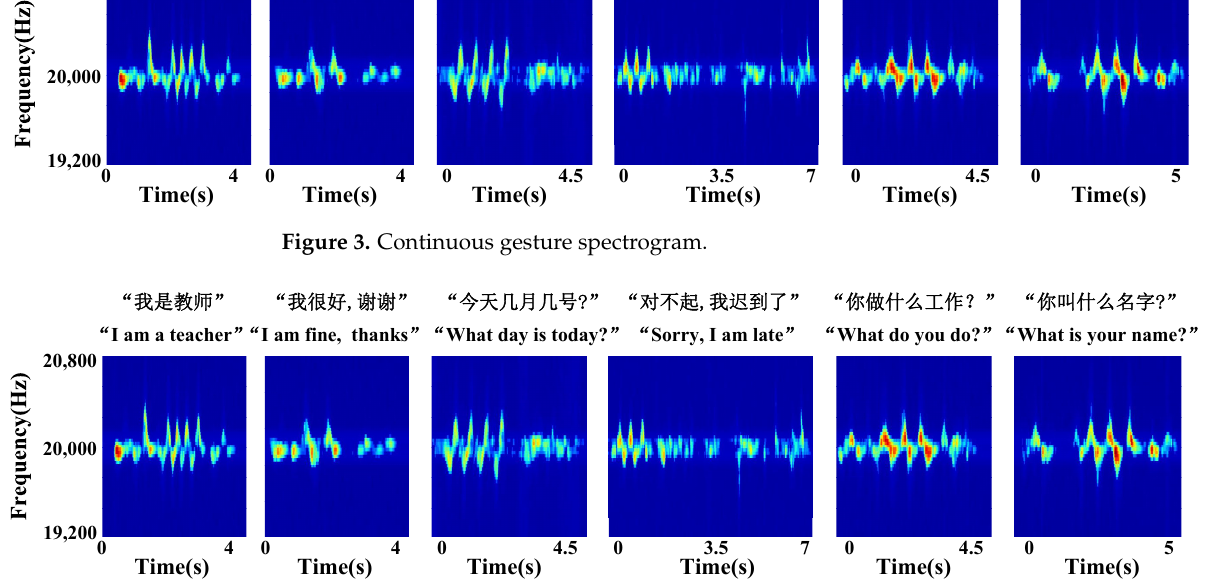
Figure 4. Sign language gesture